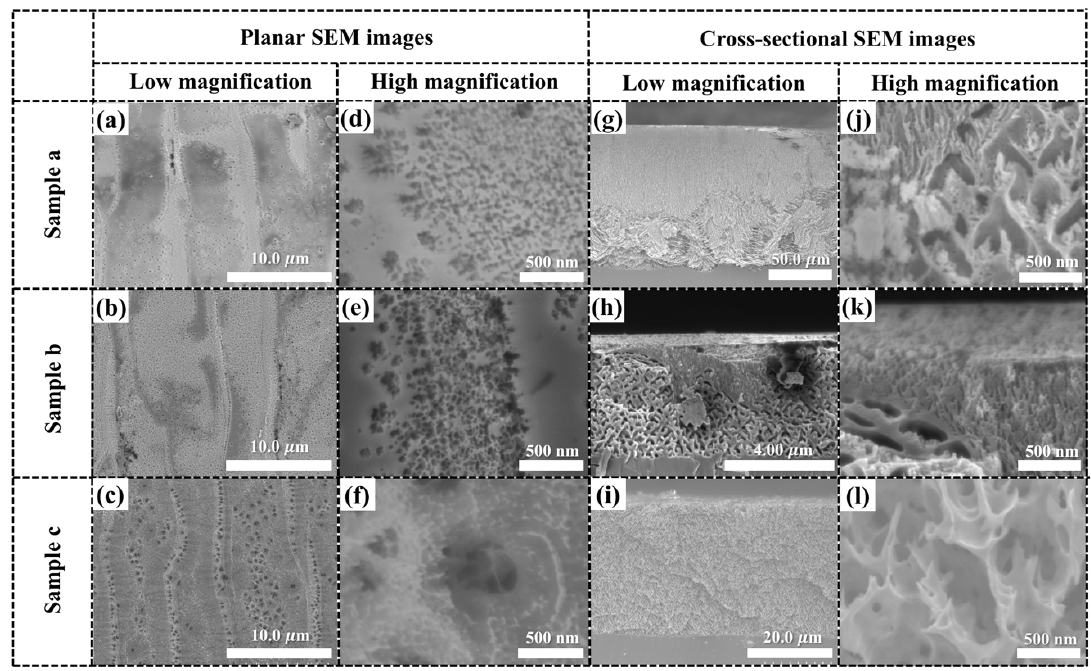
Figure 3. Planar and cross-sectional SEM images of the porous 6H–SiC samples after anodic oxidation process. Planar SEM images at ( a – c ) low-magnification and ( d – f ) high-magnification. Cross-sectional SEM images of samples a, b, and c, respectively, at ( g – i ) low-magnification and ( j – l )